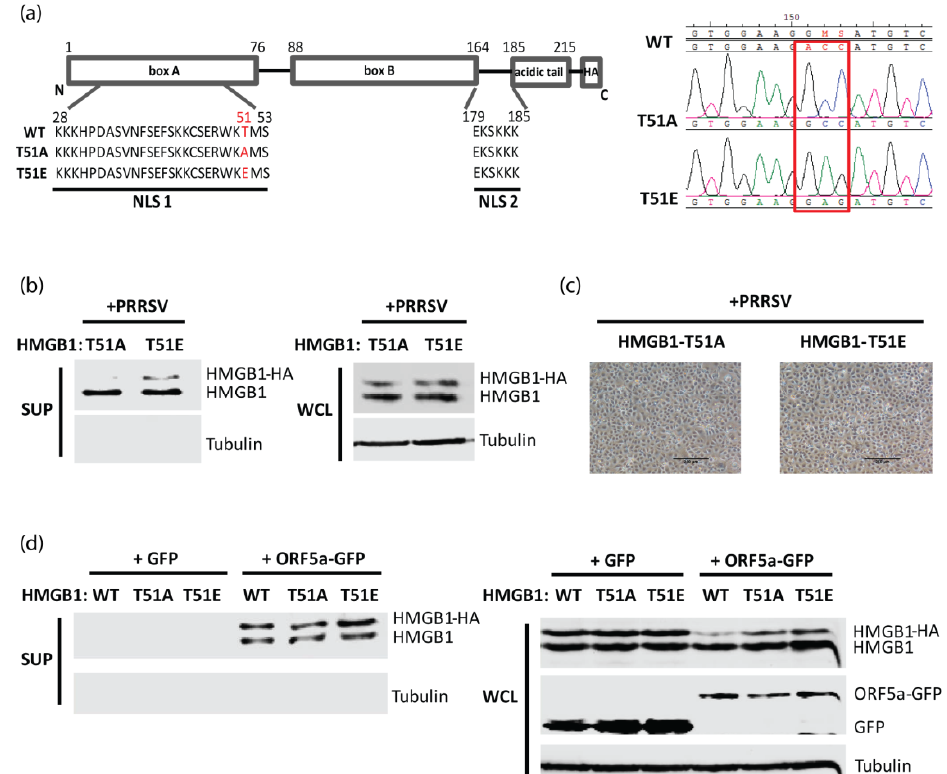
Figure 2 . The threonine-51 residue (Thr-51) within the nuclear localization sequence (NLS) of HMGB1 is responsible for PRRSV-infection induced HMGB1 secretion. ( a ) Schematic illustration of HMGB1 NLS in wild type (WT) and mutant HMGB1 plasmids. T51A or T51E denotes mutant HMGB1 with a mutation of threonine-51 to alanine or glutamic acid, respectively. The mutated amino acids are written in red. The chromatogram on the right shows the sequencing results of T51A and T51E. The mutant nucleotide sites are shown in the red square. ( b ) HMGB1 phosphorylation at Thr-51 is related to the HMGB1 secretion induced by PRRSV infection in MARC-145 cells. MARC-145 cells were transfected with plasmids expressing HMGB1-T51A or HMGB1-T51E. At 24 h post-transfection, the cells were infected with HuN4 at an MOI of 1 and harvested 24 h later. The supernatant (SUP) and whole-cell lysate (WCL) were harvested for IB. Cell morphology before the harvesting is shown in ( c ). Bars in the images denote 250 μm. ( d ) HMGB1 phosphorylation at Thr-51 is related with PRRSV ORF5a-induced HMGB1 secretion. HEK293T cells were transfected with HMGB1 WT, T51A, or T51E plasmid, along with GFP or PRRSV ORF5a-GFP plasmid. Thirty hours later, the SUP and WCL were harvested for IB with antibodies against HMGB1, GFP, and